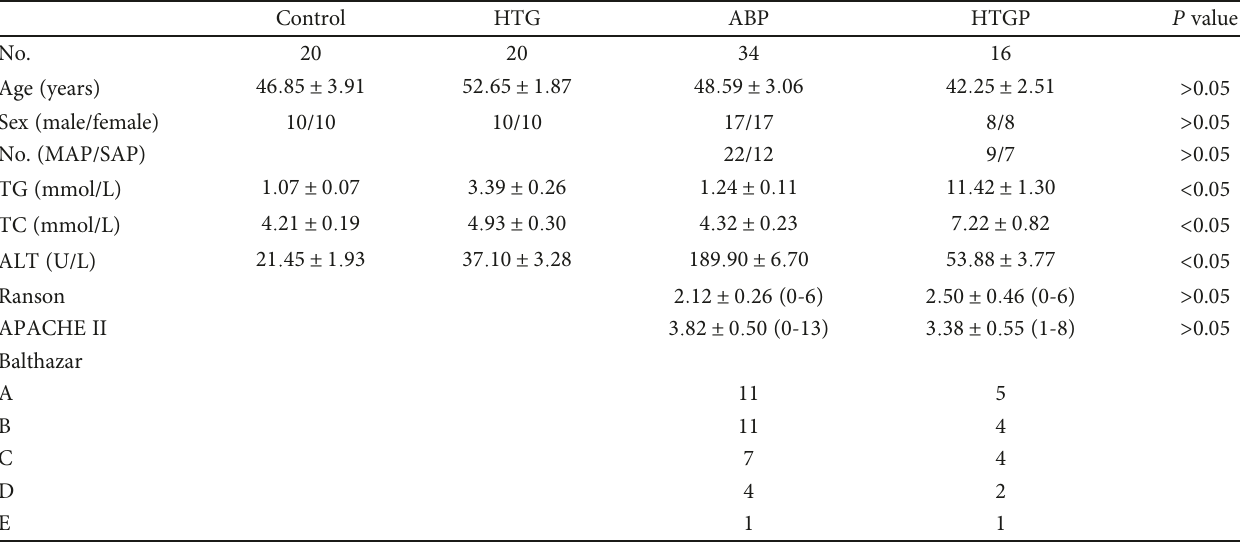
Table 1: General information of studied